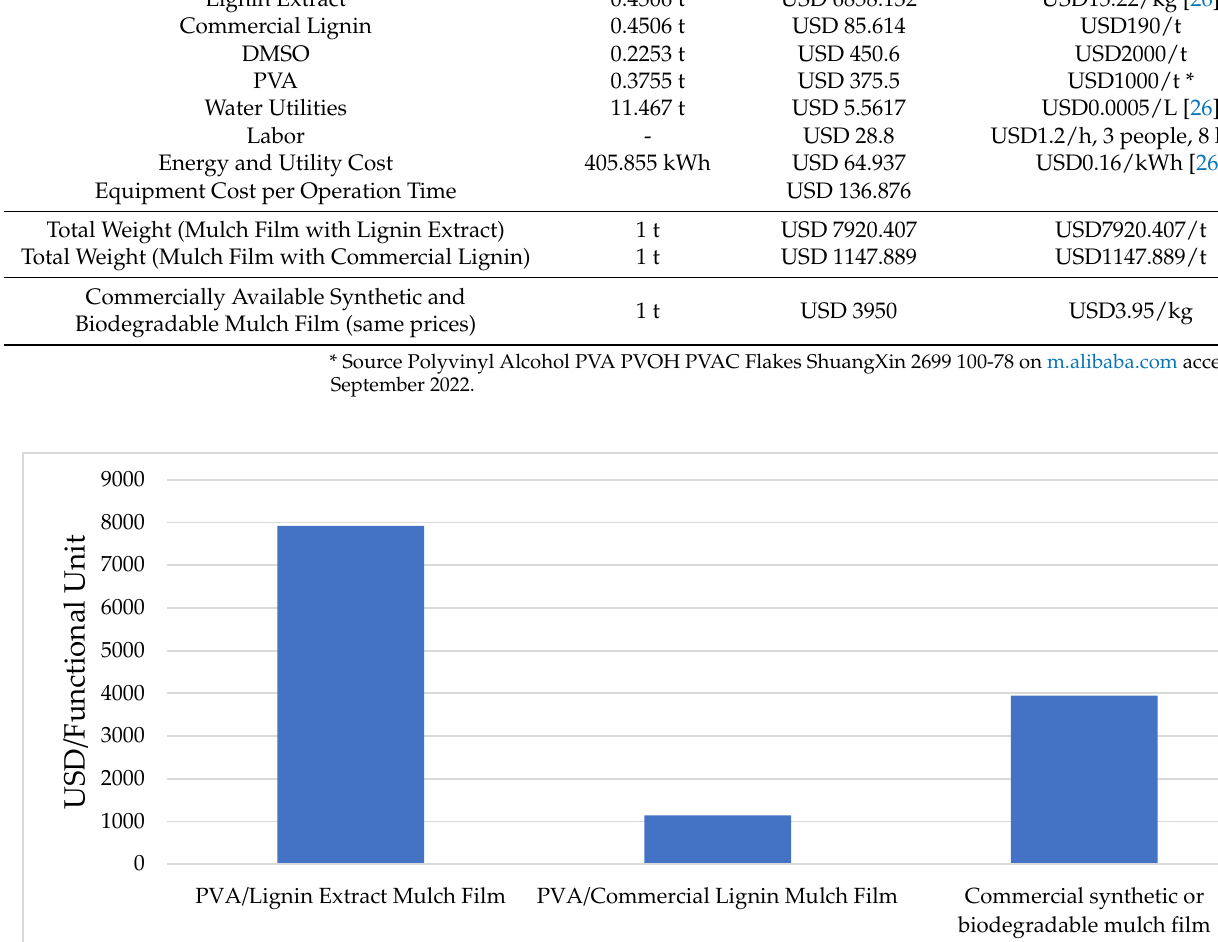
Table 6. Cost estimation of mulch film.